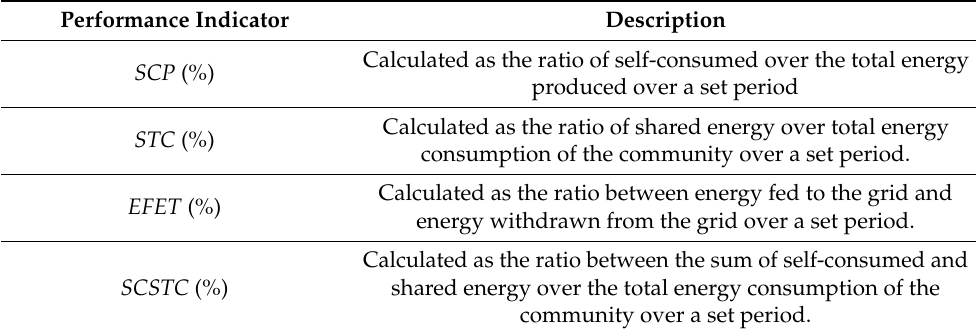
Table 3. Performance indicators used to analyze the REC performance. Performance Indicator Description Calculated as the ratio of self-consumed over the total energy SCP (%) produced over a set period Calculated as the ratio of shared energy over total energy STC (%) consumption of the community over a set period. Calculated as the ratio between energy fed to the grid and EFET (%) energy withdrawn from the grid over a set period. Calculated as the ratio between the sum of self-consumed and SCSTC (%) shared energy over the total energy consumption of the community over a set